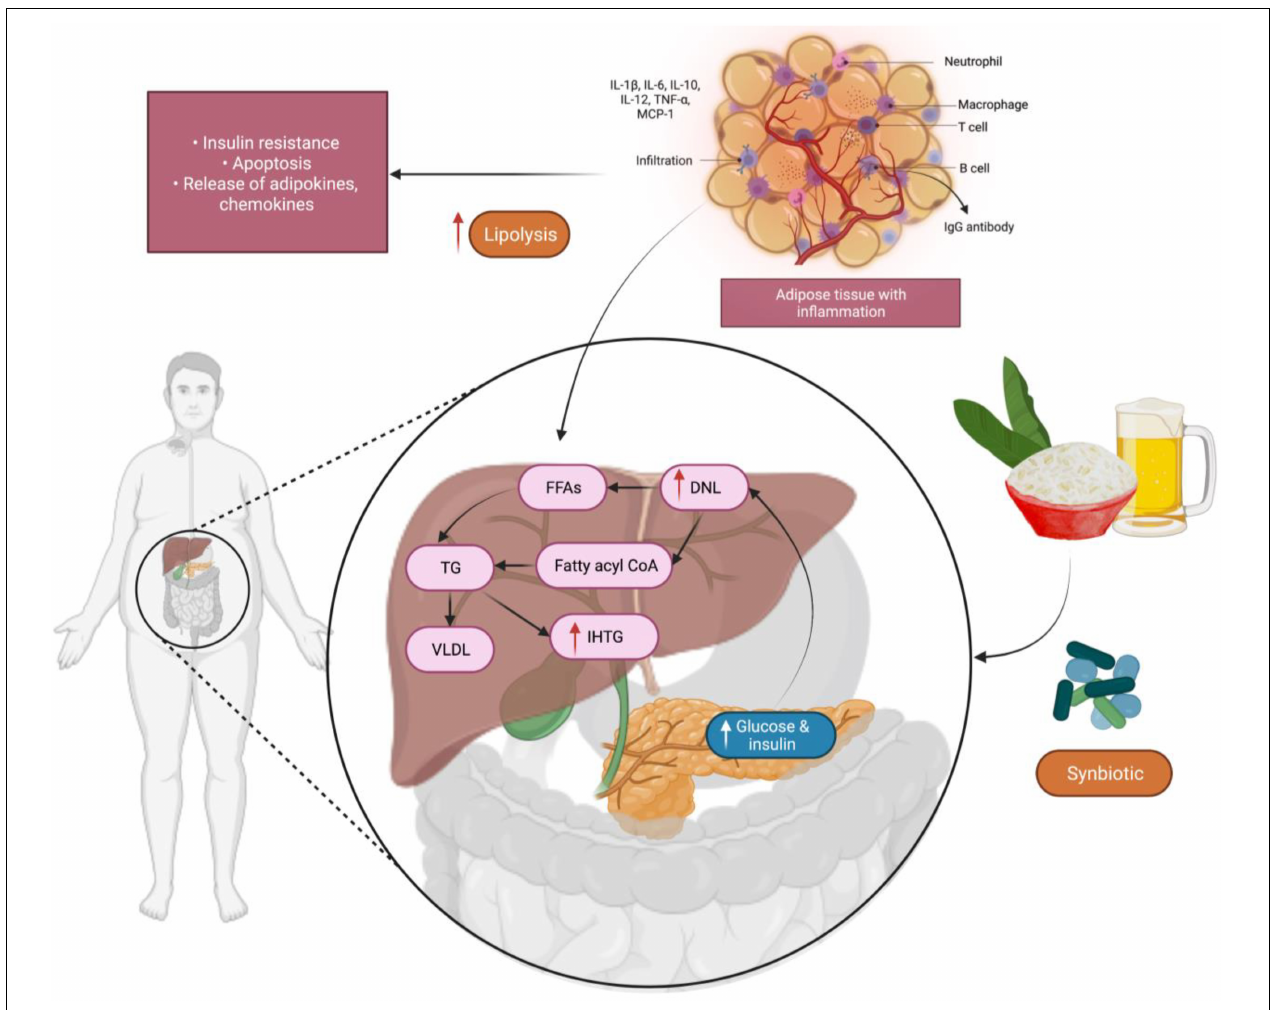
FIGURE 6 | The development of intrahepatic triacylglycerol (IHTG) in the liver, facilitated by a mechanism that enhances the production and storage of liver triacylglycerols. Synbiotics, which are made up of many beneficial probiotics, showed a significant reduction in IHTG level. IL-1 β , -6,-10,-12, Interleukin-1 beta—6,-10,-12; TNF- α , Tumor necrosis factor alpha; MCP-1, Monocyte chemoattractant protein-1; FFAs, Free fatty acids; DNL, de novo lipogenesis; TG, triglycerides; VLDL, Very low-density